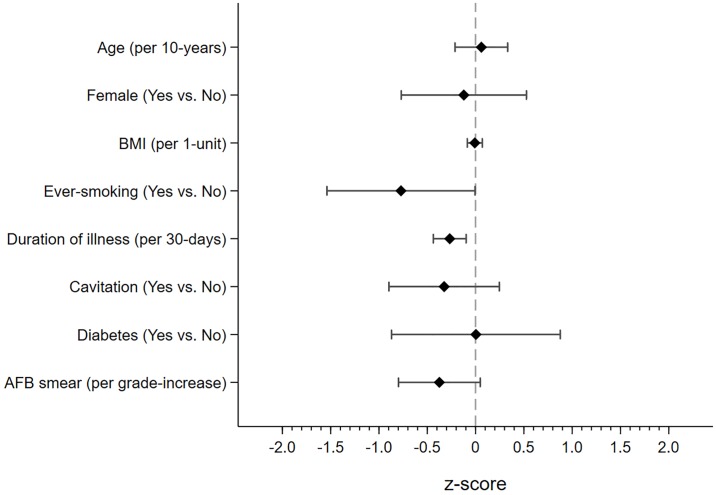
Difference in FEV1/FVC z-score by participant characteristics at treatment initiation.Figure depicts point estimate and accompanying 95% confidence interval for FEV1/FVC standardized by z-scores. Lower z-scores indicate greater degree of airflow obstruction. Regression analysis was adjusted for age, sex, BMI, ever-smoking, duration of illness, cavitation, diabetes and smear grade. BMI—body mass index, AFB—acid fast bacilli.